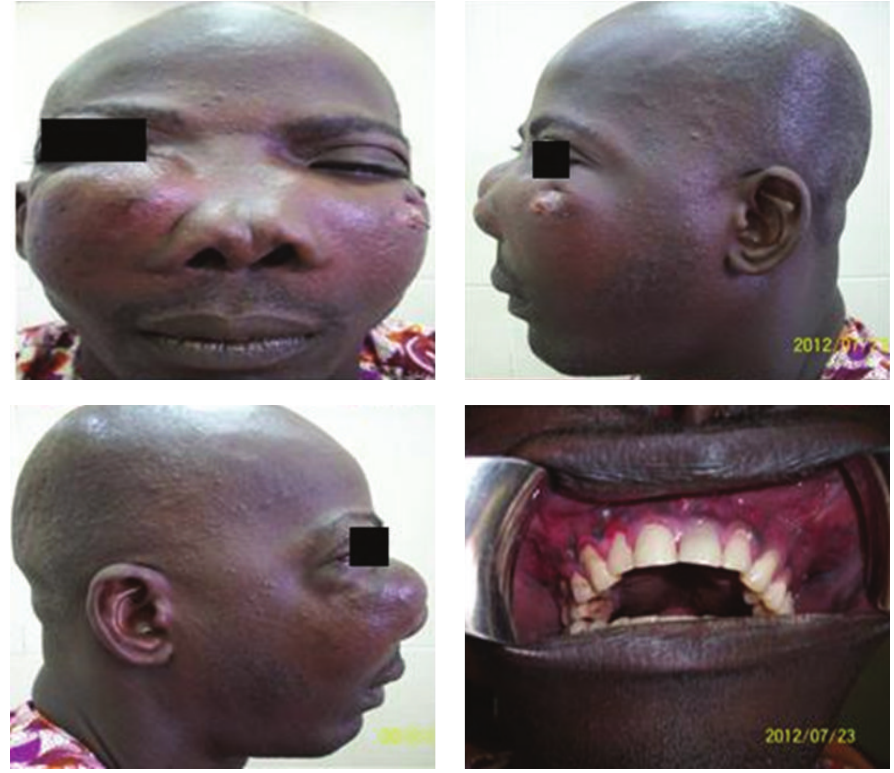
Figure 1: Clinical pictures showing a right and left maxillary swelling. The intraoral component involves both halves of the